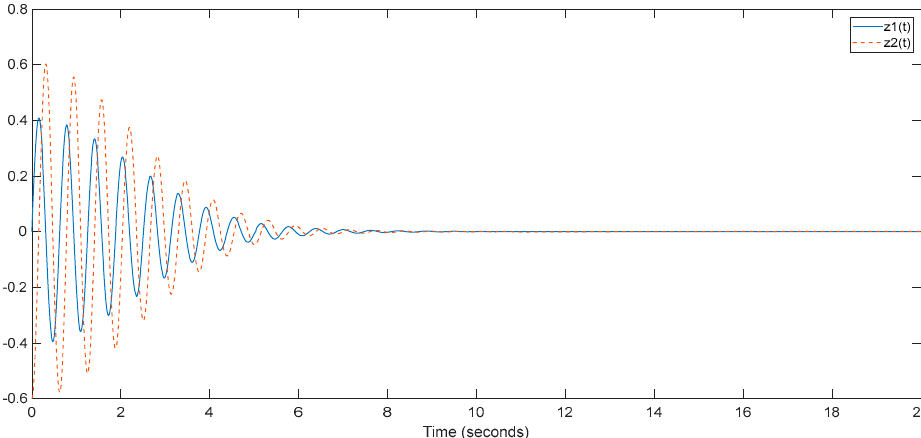
Figure 3. Regulated output for synchronous signal in (19) and input in (20) with zero initial condi ‐ tion.